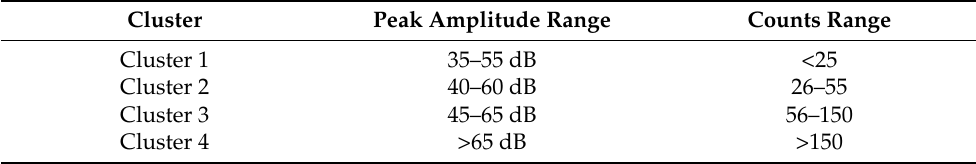
Table 3. Cluster details of the AE signals based on peak amplitude and